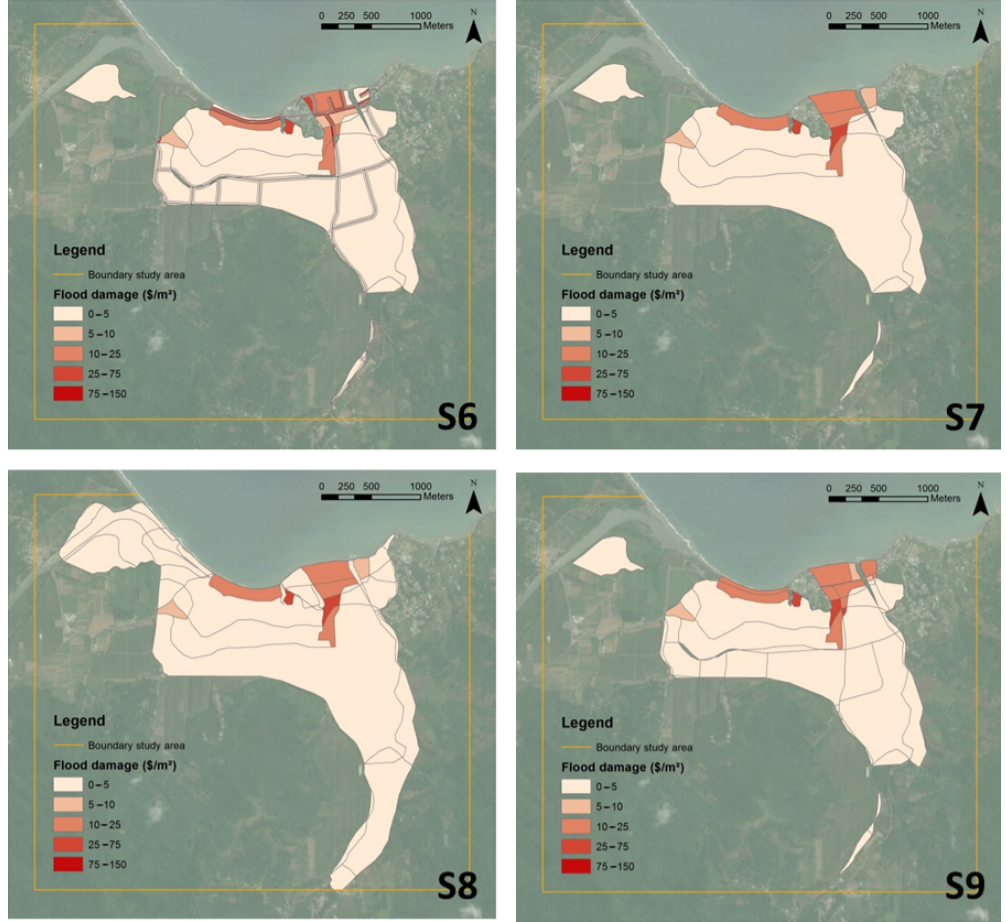
Figure 6. Damage maps for Annotto Bay for S6, S7, S8 and S9. Top left: (S6) road classes are unknown; top right: (S7) all roads are unknown and not taken into account; bottom left: (S8) all roads are unknown but taken into account as a percentage of land use; bottom right: (S9) roads are only used to divide land use polygons – no road